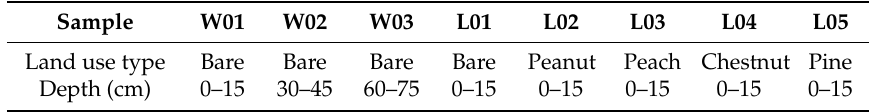
Figure 1. Diagram of experimental plot location ( a ) is a map of the location of the experimental plot. ( b ) is the experimental plot. Table 1. Sample information sheets (L01 and W01 were the same sampling points. To better compare di ff erent conditions, two numbers were